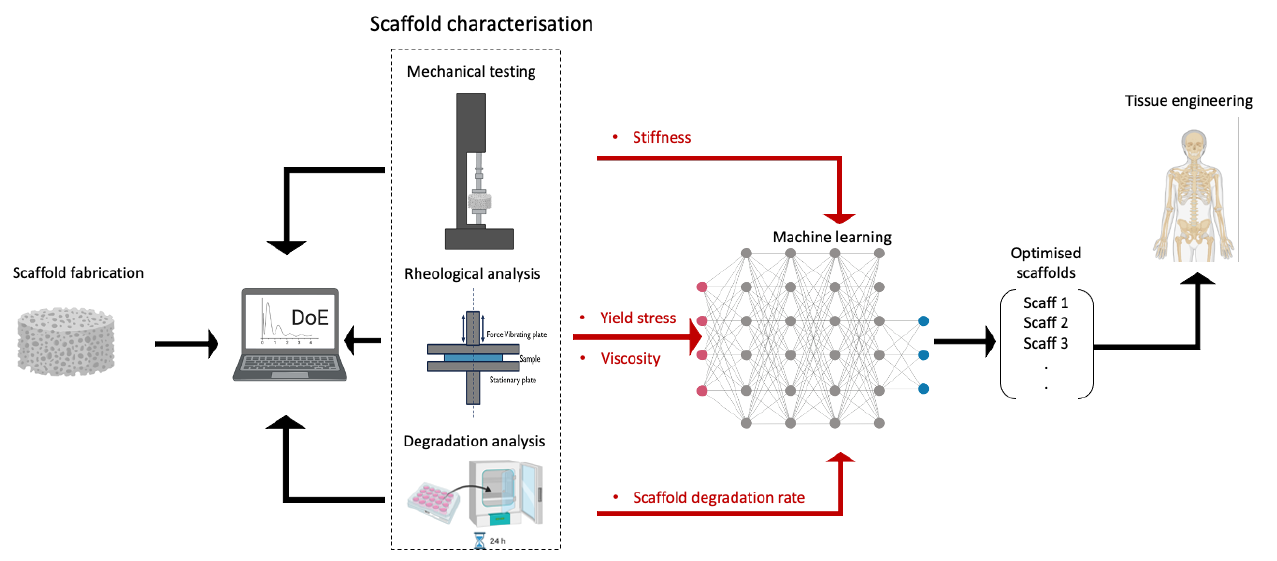
Figure 1. DoE and ML workflow to optimise the material that will be used for the TE applications.